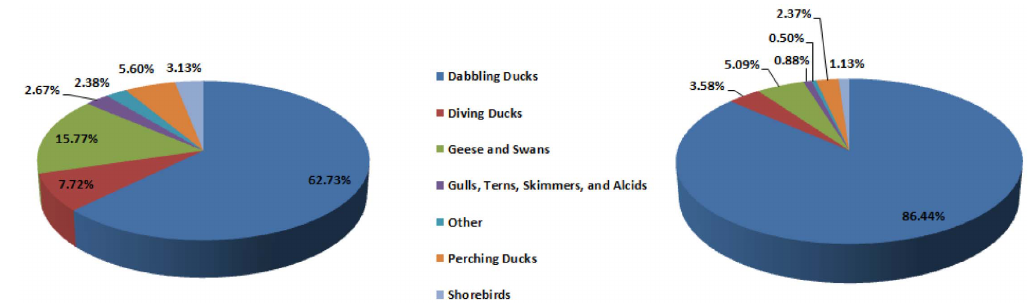
Figure 2. Percentage of samples collected for wild bird influenza virus surveillance by avian functional group (a); and the proportion of samples by avian functional group (b) that were influenza virus positive by M gene rRT-PCR (n=197,885).